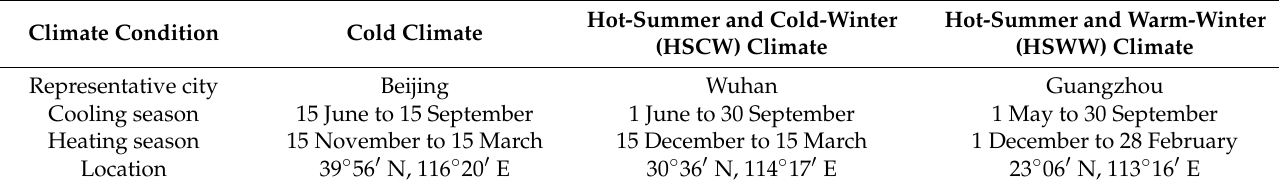
Table 2. Detailed information of the three climate